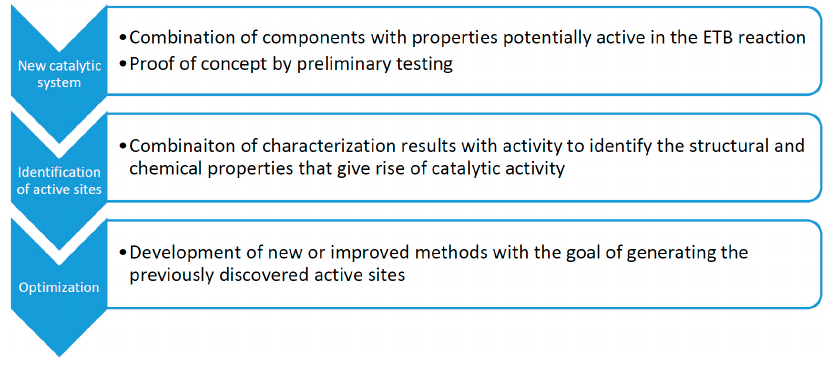
Figure 14. Development progress of Ag/Zr/BEA as exemplified by Ivanova et al.